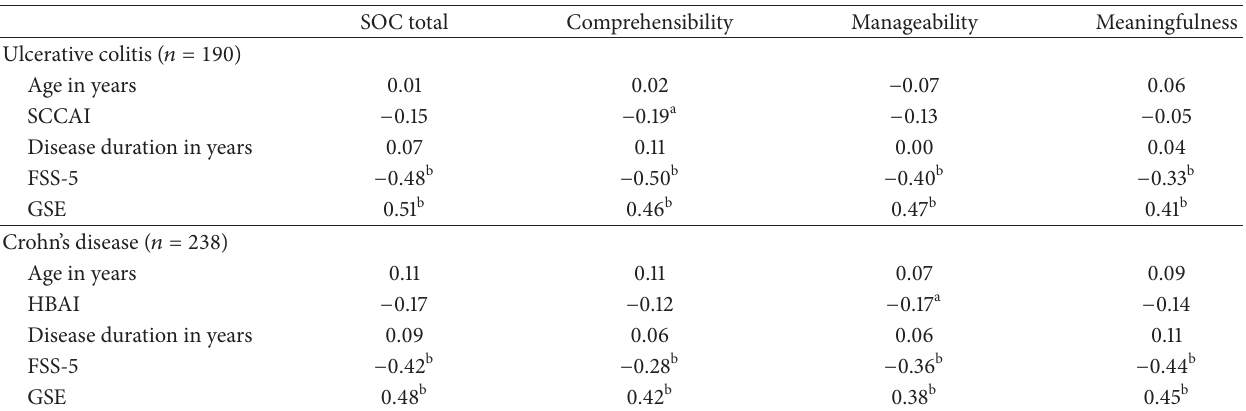
Table 3: Bivariate correlations (Pearson’s 𝑟 ) between age, disease activity scores, disease duration, fatigue interference, self-efficacy, and SOC in ulcerative colitis and Crohn’s disease patients.